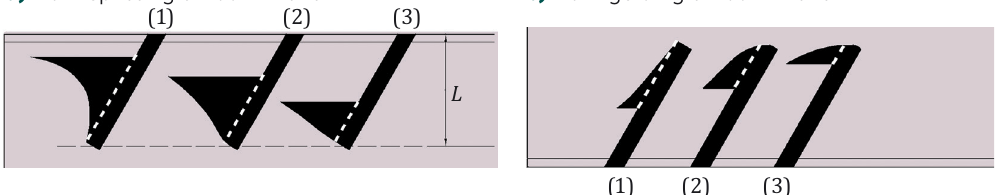
Figure 18. Geometry plan of proposed patterns for guide bank at a skew of